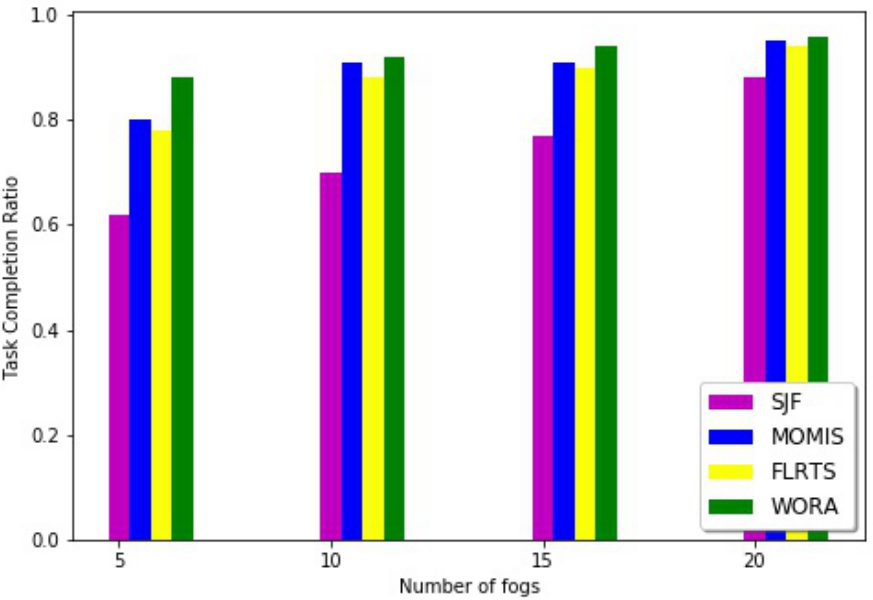
Figure 10. Compuatation of successful completion of task ratio for fog with 500